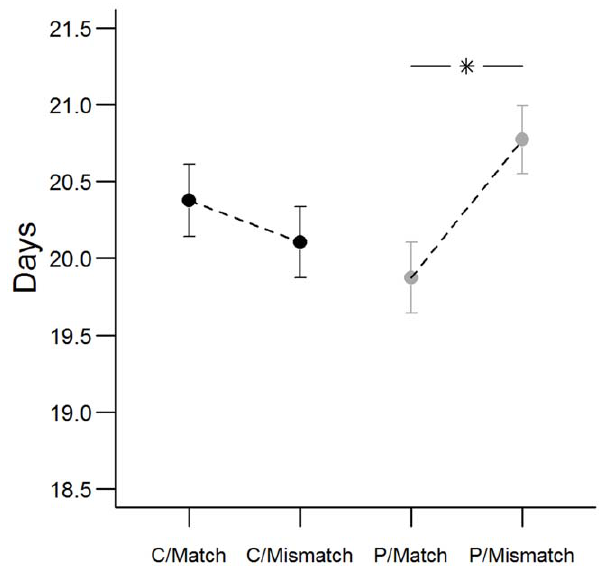
Figure 1. Fledging Age. Fledging age (model estimations of mean 6 SE) for offspring of mothers exposed to either control birds (C) or to predatory birds (P) before and during egg-laying, raised either under matching or mismatching conditions. Asterisk represents significant difference ( p , 0.05).